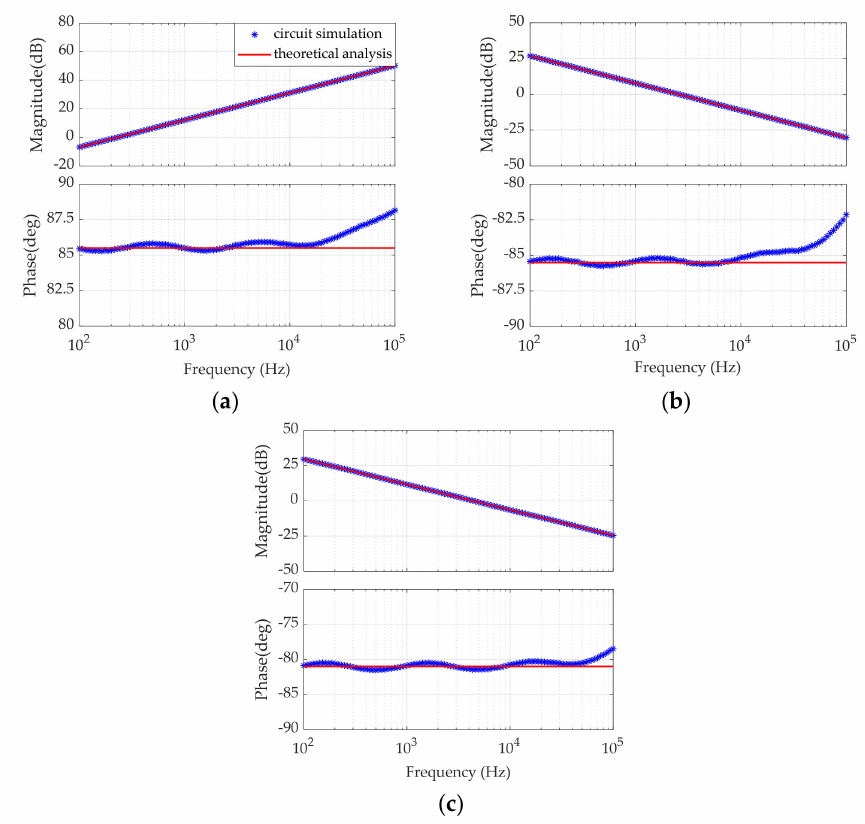
Figure 7. The Bode diagrams of the constructed fractional-order inductor and fractional-order capacitor. − α ( a ) L m α = 1 mH/ s 1 and α = 0.95. ( b ) C β = 100 µ F / s 1